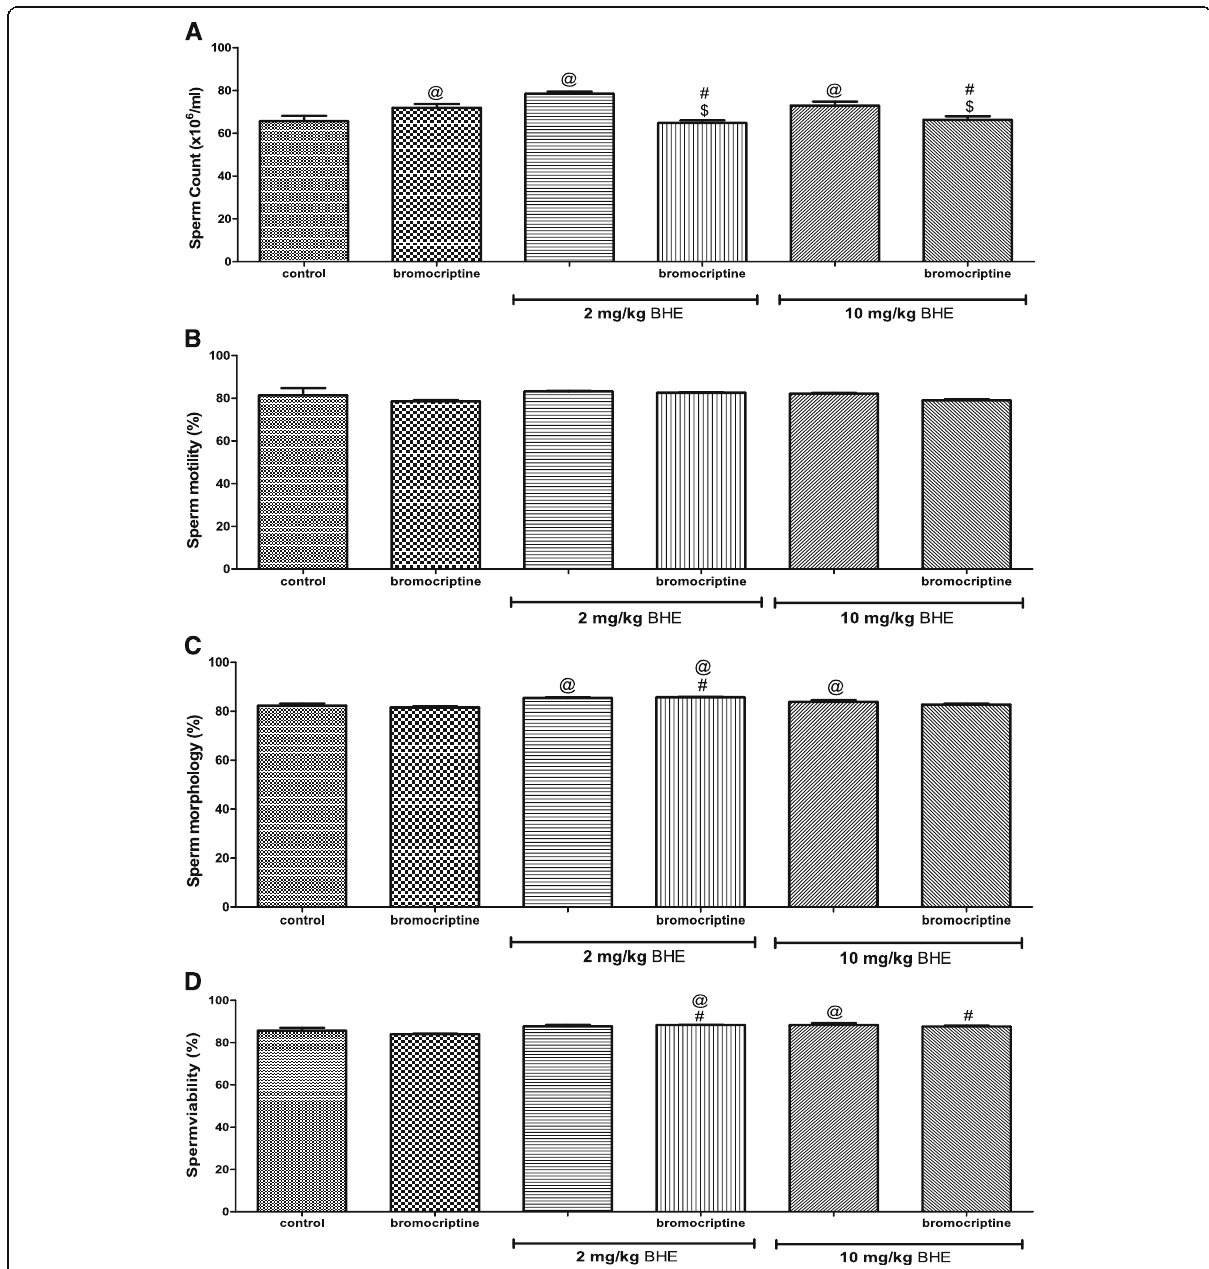
Fig. 1 Effects of bromocriptine and/or BHE on semen parameters ( a Sperm count, b sperm motility, c sperm morphology, d : sperm viability) in rats. BHE denotes Benin republic hemp ethanol extract; @ p < 0.05 vs. control; # p < 0.05 vs. bromocriptine; $ p < 0.05 vs. corresponding BHE of same